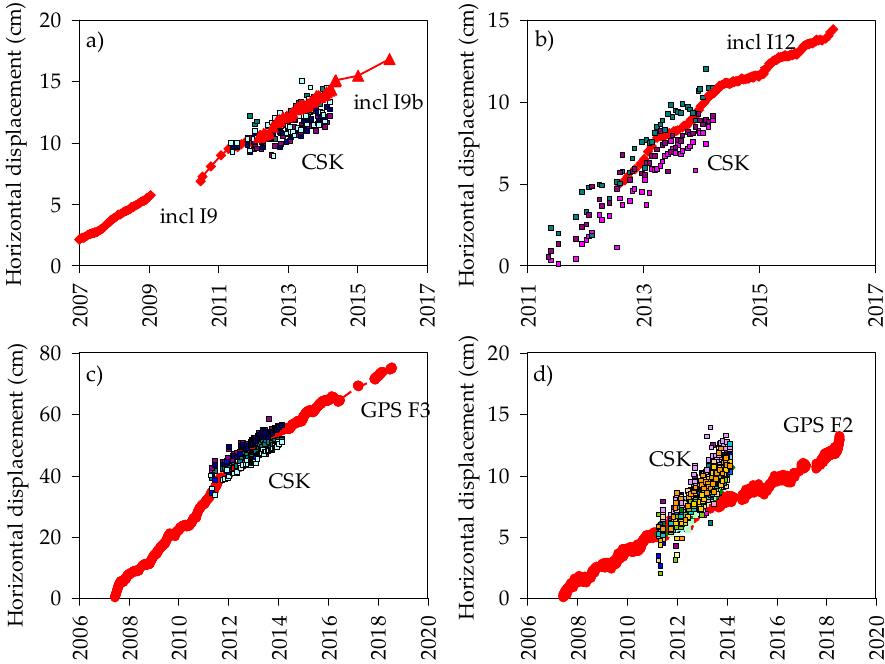
Figure 12. Comparison of displacements obtained from PSInSAR data, GPS, and inclinometers in zones a , b , c , and d of Figure 11.